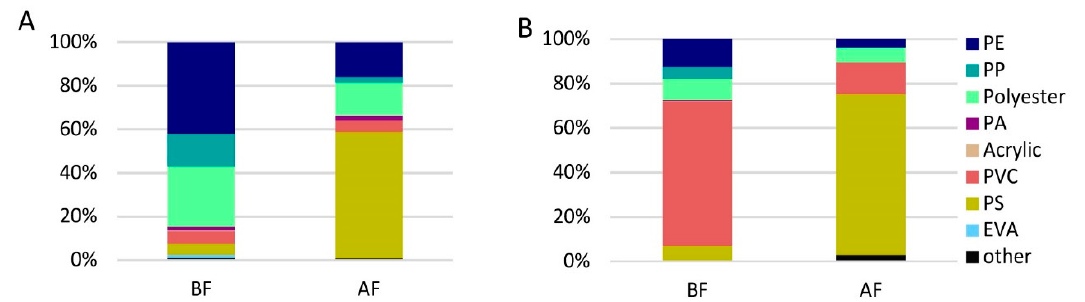
Figure 1. The distribution of polymers based on the number of particles ( A ) and mass of particles ( B ) in wastewater before (BF) and after (AF) disc filter treatment. The polymer group “other” denotes polycarbonate, polyurethane, ABS, epoxy, phenoxy resin, cellulose acetate, and acrylate MPs collectively.